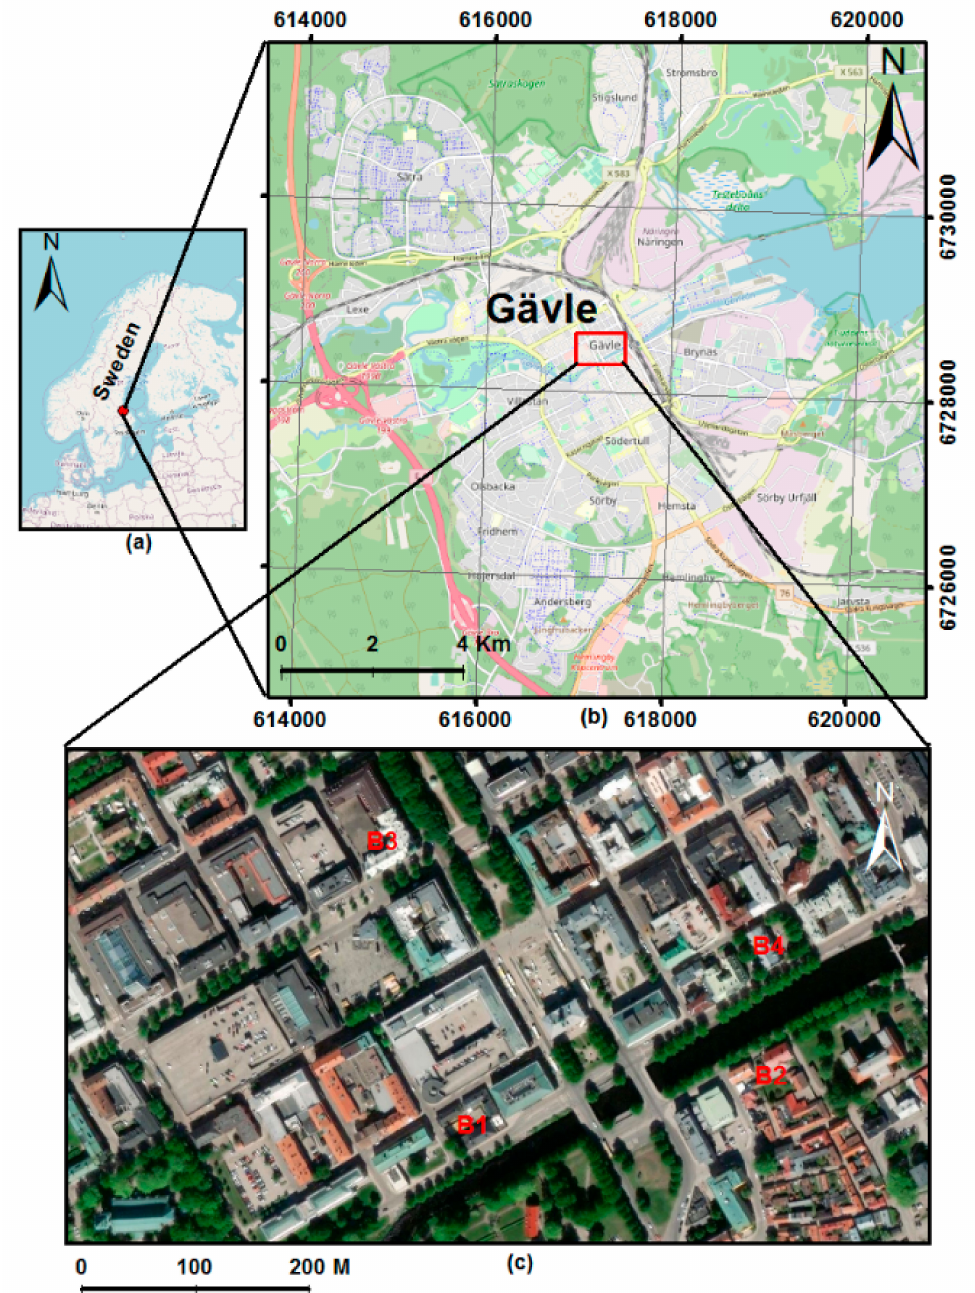
Figure 1. Shows the study area of Gävle city ( a ) location map ( b ) map of the urban zone and ( c ) locations of the four buildings (B-1, B-2, B-3, and B-4) which have been measured and monitored using precise leveling between 1974 and 2019. Coordinate system: SWEREF 99